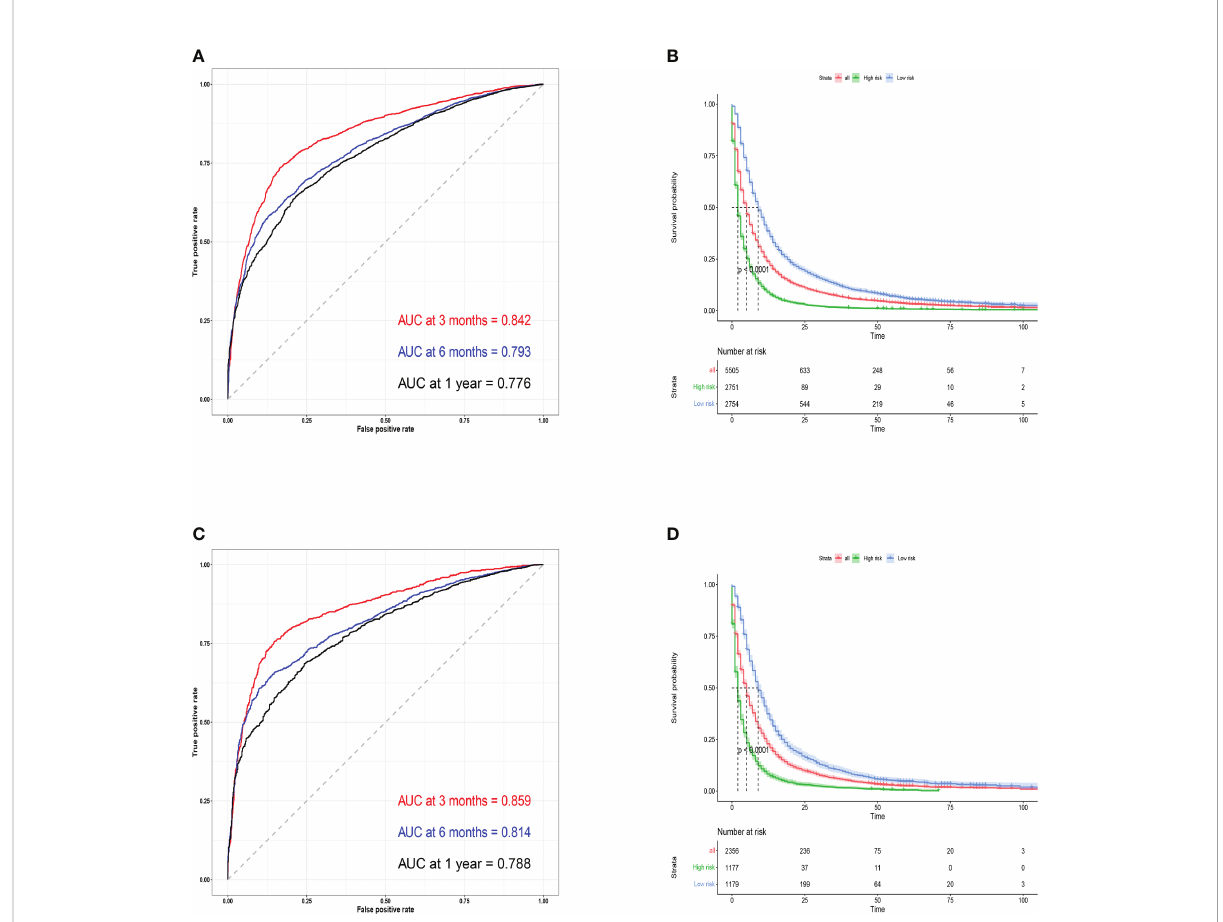
FIGURE 3 Training cohort ROC curves (A) and validation cohort ROC curves (C) for predicting 3- month, 6-month, and 1-year OS. Kaplan-Meier survival curves for training (B) and validation cohorts (D)